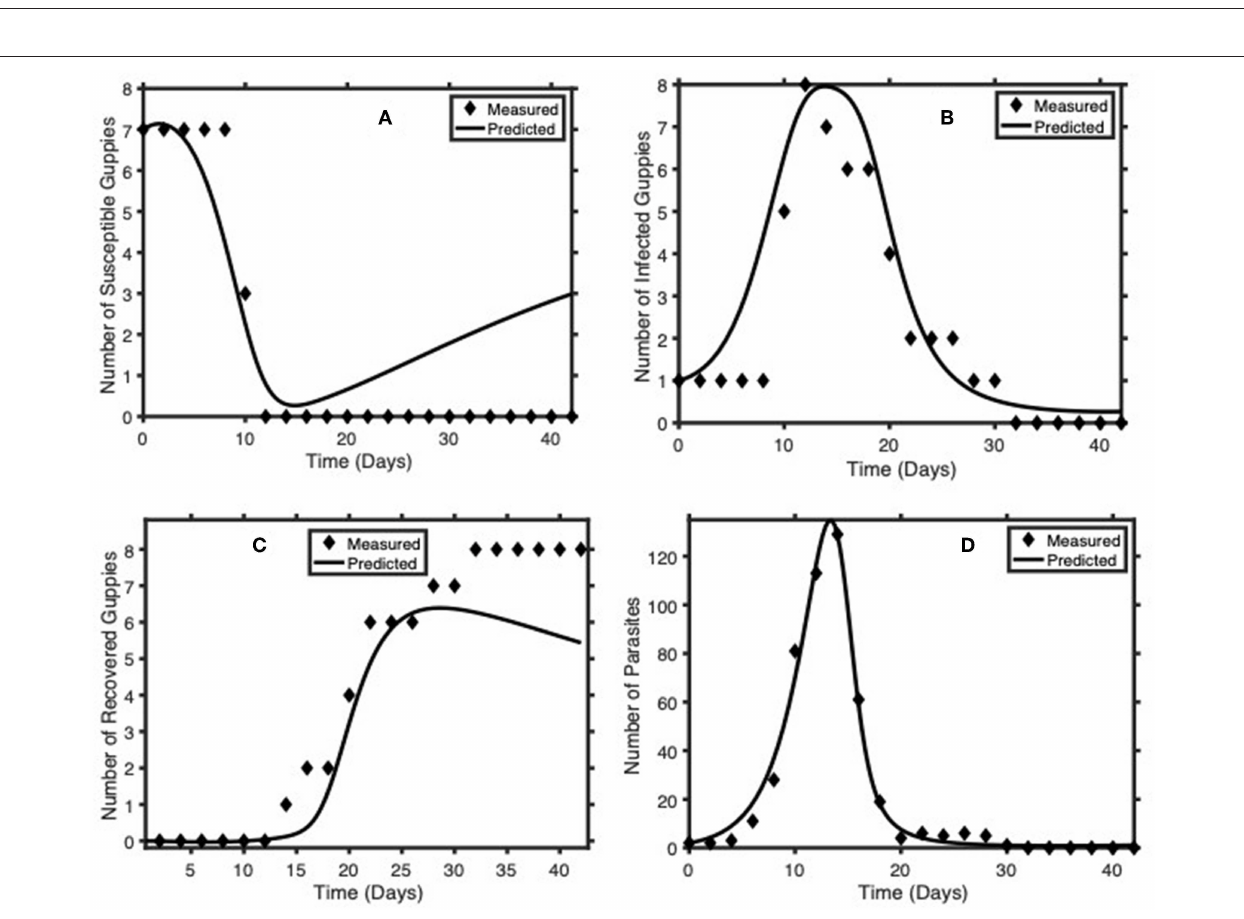
FIGURE 3 | Comparison of model predictions (solid line) of Guppy- Gyrodactylus dynamics using the parameters in Table 1 with measured values from averages of laboratory results (diamonds). (A–D) we plot the time course dynamics of the number of susceptible guppies, infected guppies, recovered guppies and Gyrodactylus per tank,